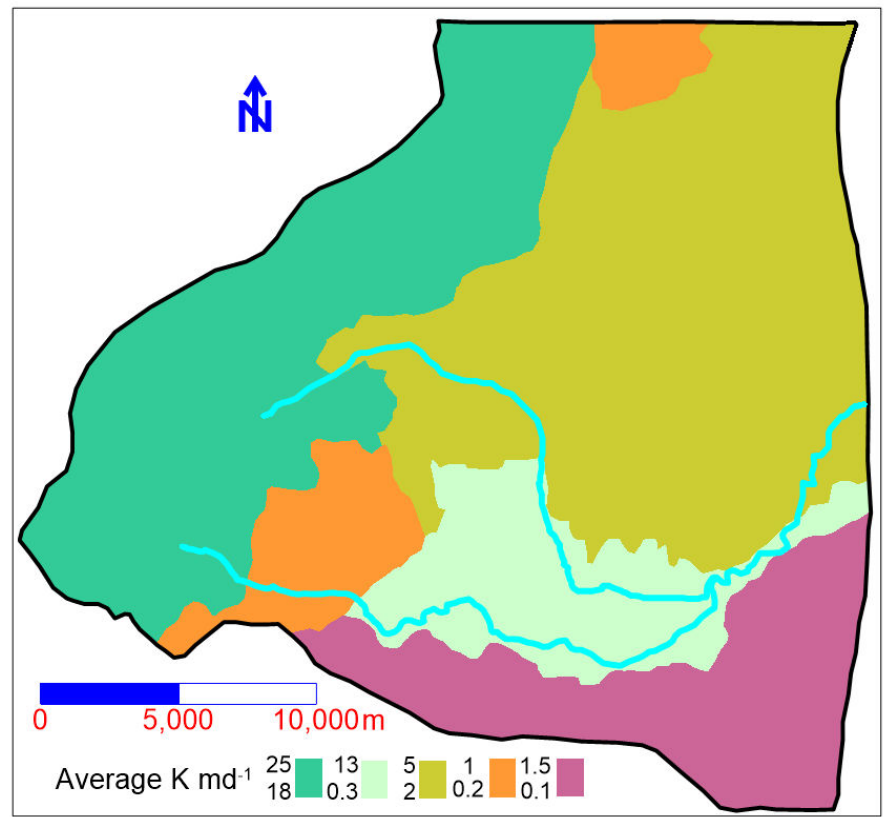
Figure 8. Spatial distribution of the hydraulic conductivity (md − 1 ) in the aquifer system of NEMH, after [31]. Groundwater